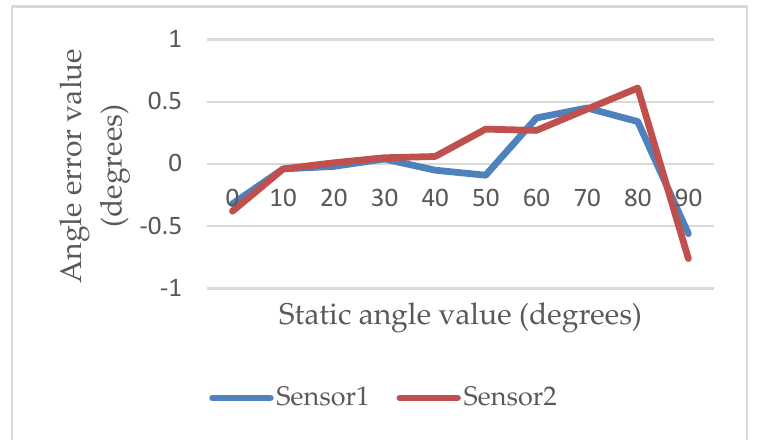
Figure 3. ROMSS verification in static sensing.